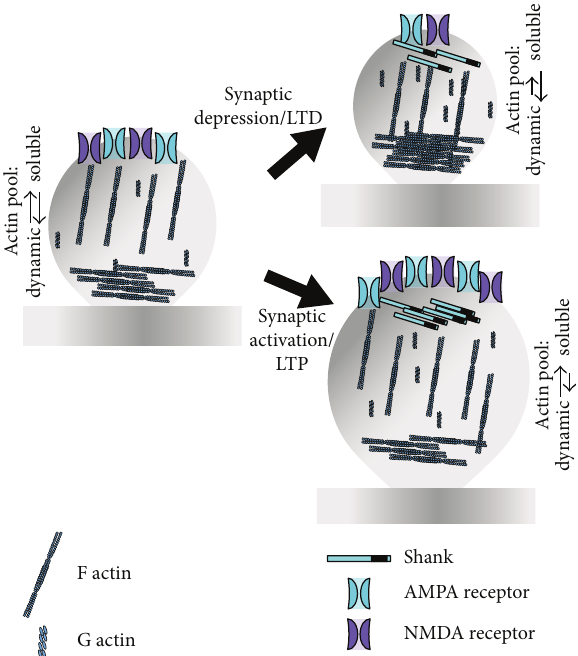
Figure 3: Activity dependent spine morphology alteration. Upon synaptic activation or in case of LTP, rapid actin remodeling favors the formation of filamentous or F actin. This can have twofold effects: one is the spine enlargement and the other one is that actin is able to anchor additional receptors at the PSD. On the other hand, synaptic depression or LTD is often coupled with spine shrinkage. This is realized by the depolymerization of F actin. In addition to such depolymerization, the number of receptors may be decreased, thus making the dendritic spine less responsive to synaptic stimulation. The changes in actin remodeling and receptor trafficking can occur together or independent of each other. Spine shrinkage and enlargement also depend on scaffolding proteins of the Shank family that increase in number at the PSD upon LTP and decrease upon LTD.